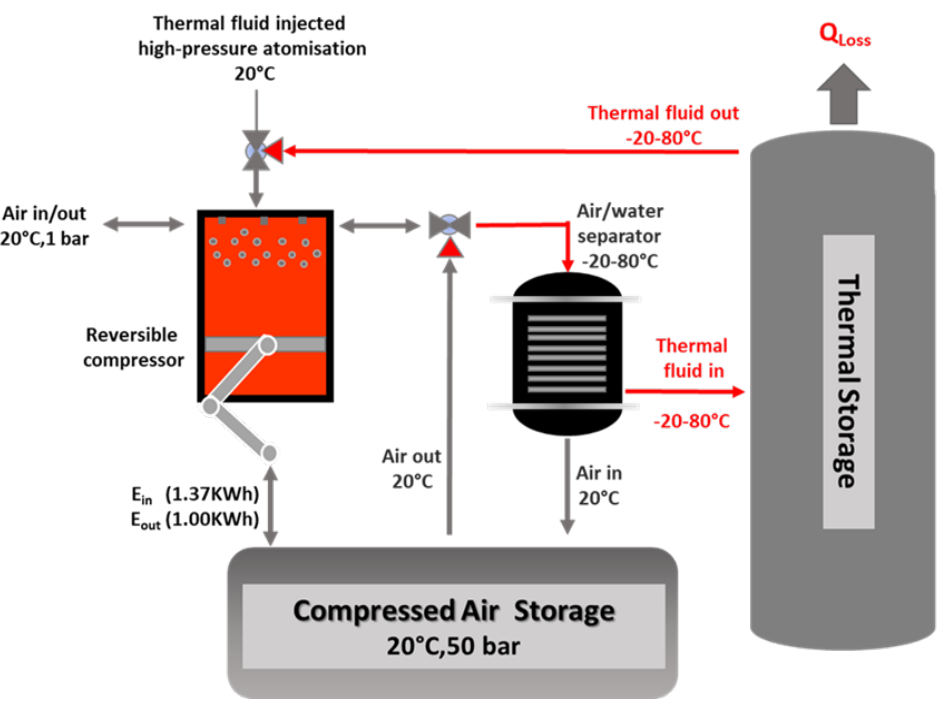
Figure 8. Schematic diagram of a droplet-based isothermal CAES (I-CAES) system producing 1.0 kWh output power, adopted from [84].